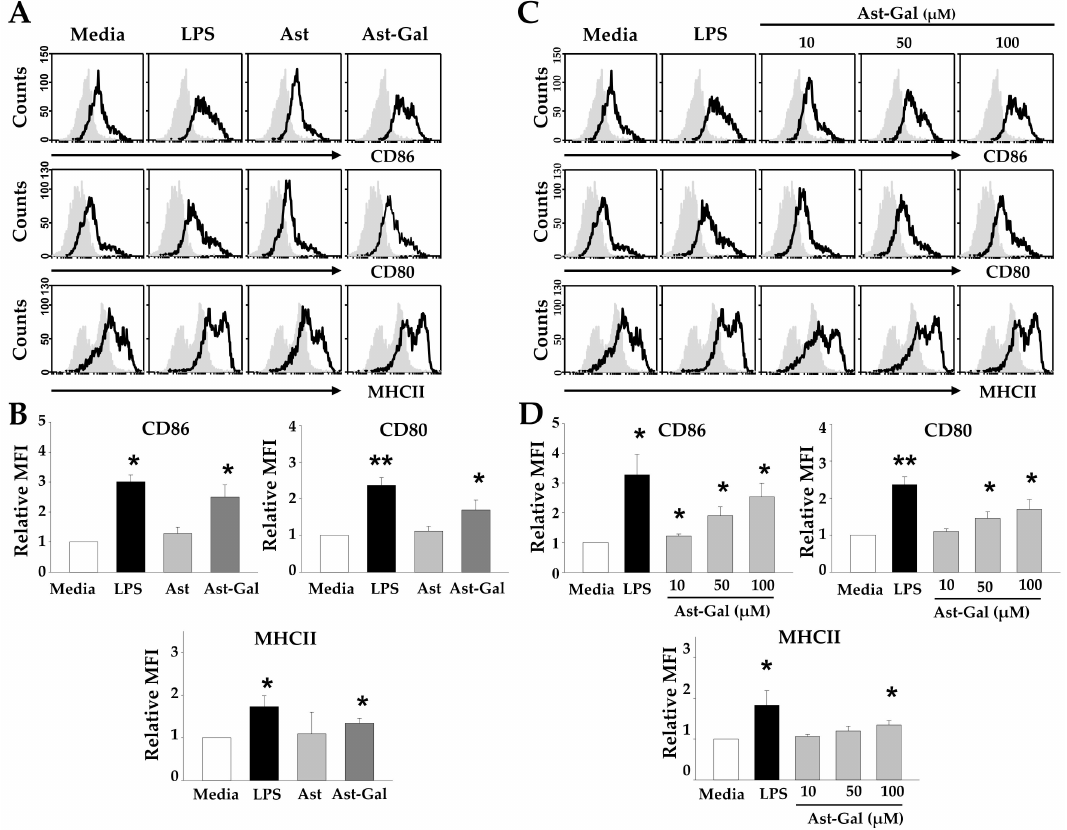
Figure 1. Ast-Gal induces expression of maturation/activation-related surface molecules on DCs. Bone marrow cells were isolated from C57BL/6 mice and differentiated into iDCs, as described in Materials and Methods. ( A ) iDCs (5 × 10 5 cells/well) were cultured for 18 h in the presence of an indicated concentration of Ast (100 µ M), Ast-Gal (100 µ M), or lipopolysaccharide (LPS) (100 ng/mL). The expression of CD80, CD86, and MHCII molecules on CD11c + cells was determined by cytofluorometric analysis using PE-conjugated anti-CD80, PE-conjugated anti-CD86, and FITC-conjugated anti-MHC II antibodies, respectively (unshaded areas) or with isotype control antibodies (shaded areas). ( B ) The results from (A) are summarized as mean ± SD ( n = 3). * p < 0.05, ** p < 0.01 compared with media-treated DCs. ( C ) iDCs were cultured for 18 h in the presence of various concentrations (10, 50, and 100 µ M) of Ast-Gal, or LPS (100 ng/mL). ( D ) The results from ( C ) are summarized as mean ± SD ( n = 3). The results shown in ( A ) and ( C ) are representative of data from three independent experiments. * p < 0.05, ** p < 0.01 compared with media-treated